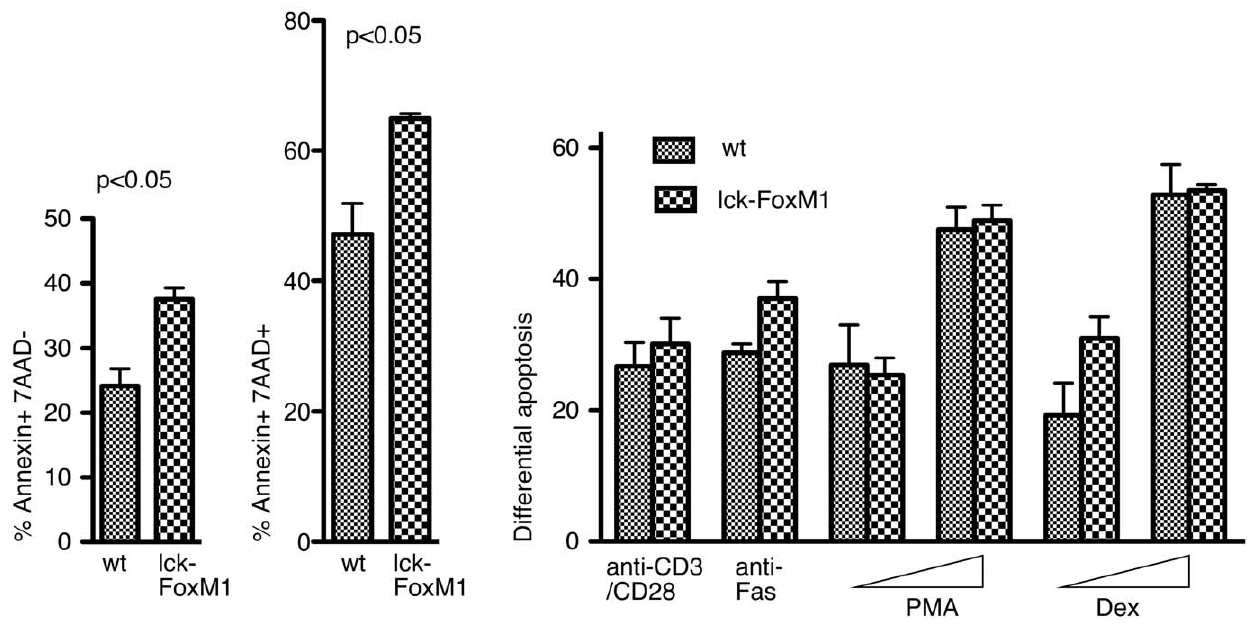
Figure 5. Lack of FoxM1 expression increased apoptosis of DP thymocytes in culture. Left panel: apoptosis of DP thymocytes (Annexin V + 7ADD 2 ) culture in vitro for 24 hr. Middle panel: total number of cell death as measured by Annexin V + 7ADD + of DP thymocytes culture in vitro for 24 hr. Right panel: DP thymocytes from Lck-FoxM1 mice or their wild-type littermate controls were stimulated with anti-CD3/CD28, anti-Fas antibody, PMA phorbol ester (PMA) or dexamethasone (Dex). The extent of apoptosis (% Annexin V positive, 7-AAD negative cells) was measured 24 hours later.